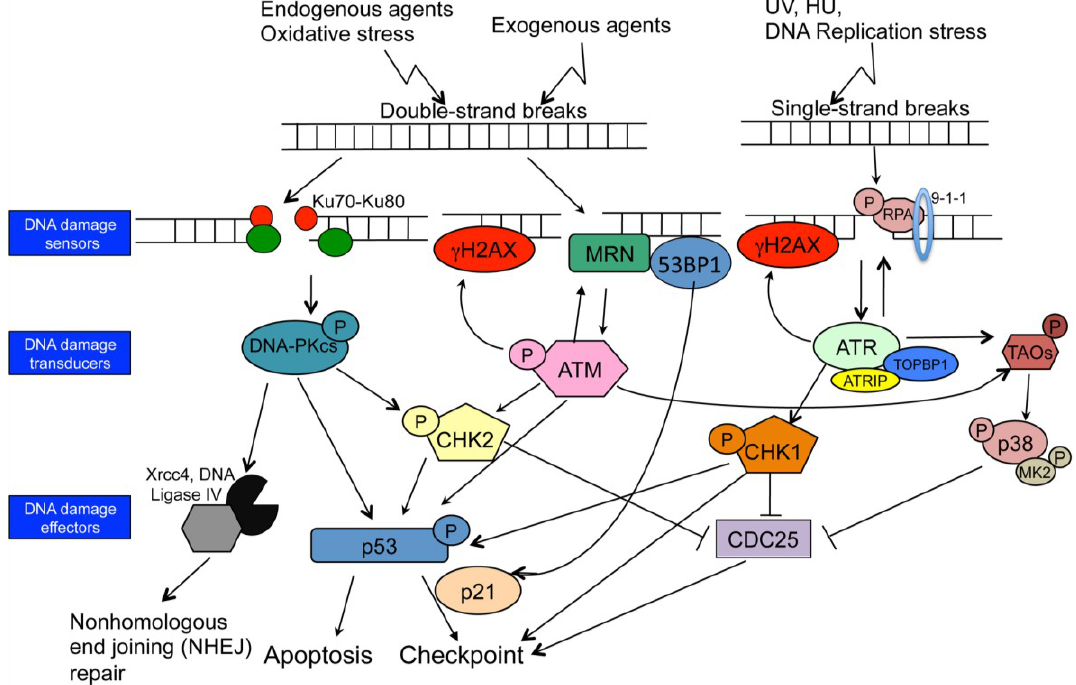
Figure 1. DNA damage-induced cell cycle checkpoint network. Schematic representation of ATM, ATR and DNA-PK signaling pathways. DNA-PK responds to DNA double-strand breaks and regulates nonhomologous end joining (NHEJ). The DNA ends are captured by the KU heterodimer. Ku regulatory proteins recruit DNA-PK to double-strand breaks; two DNA-PKcs molecules in concert tether DNA ends together and recruit the DNA Ligase IV–XRCC4 complex to rejoin broken DNA ends. ATM responds to DNA double-strand breaks; phosphorylates H2AX and NBS1, which localize to sites of DNA damage, where upon the MRN complexes form. ATM activation regulates cell-cycle checkpoints through the phosphorylation of CHK2 and p53. ATR is activated in response to single-stranded DNA (ssDNA). Activation of ATR requires TopBP1. ATR is recruited to RPA-coated ssDNA by its binding partner ATRIP. ATR regulates the cell-cycle through activation of CHK1. Both ATM and ATR are required to activate the p38MAPK/MK2 effector kinase complex downstream of TAO kinases in response to DNA damage. The three effector kinases, CHK1, CHK2, and MK2 are directly responsible for inhibitory phosphorylation on members of the Cdc25 family. Arrows indicate the flow of the respective DDR